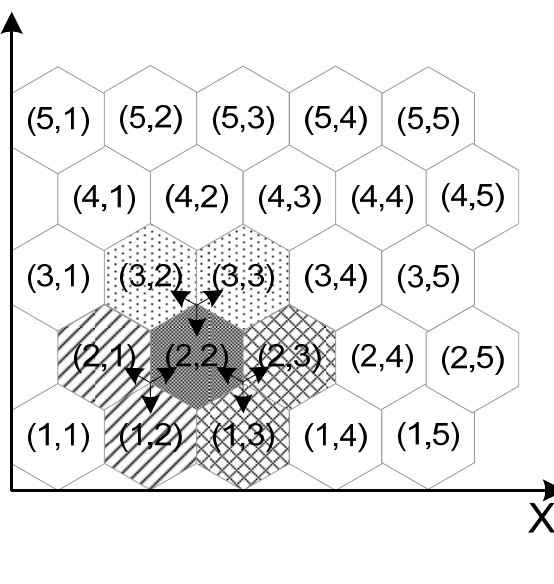
Figure 4. Hexagonal group-based deployment